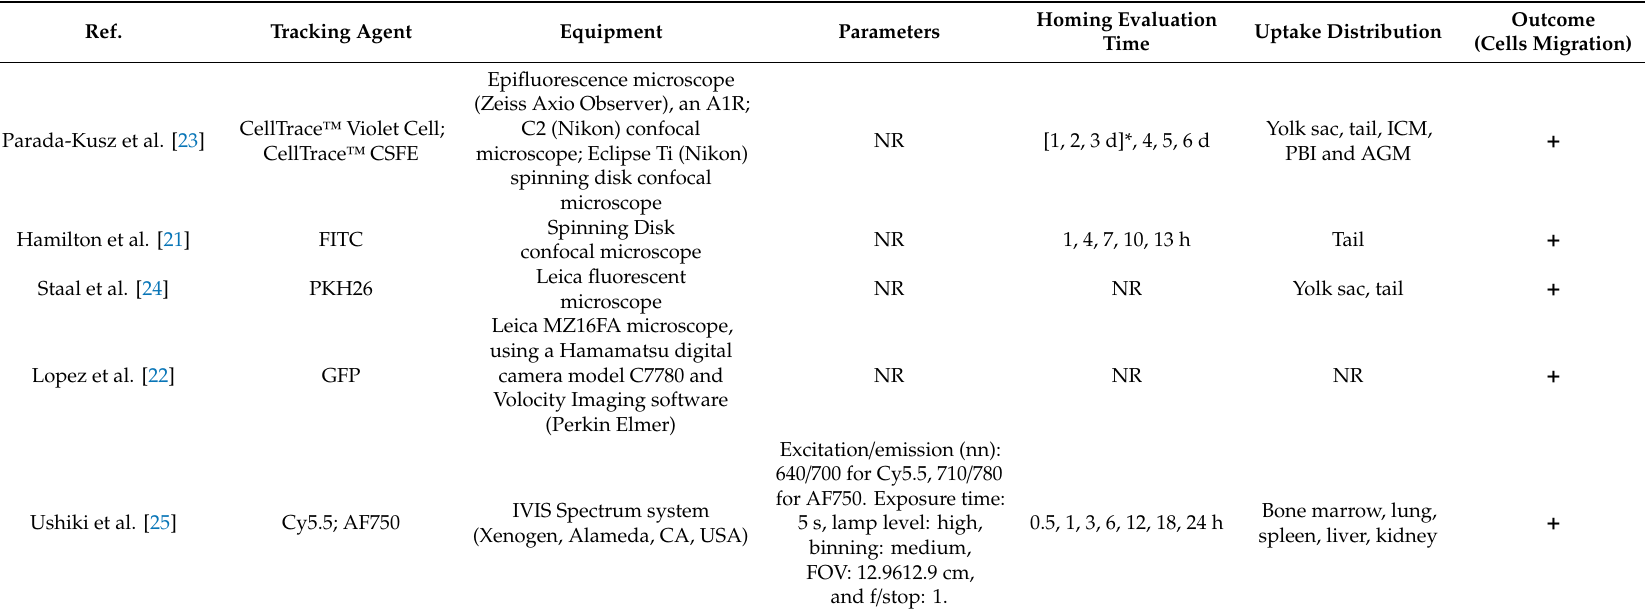
Table 9. HSC migration homing and tracking by fluorescence